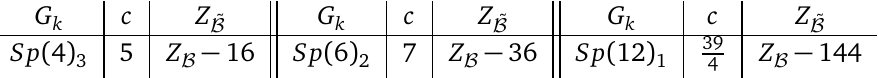
center symmetry. Based on the fact that 2